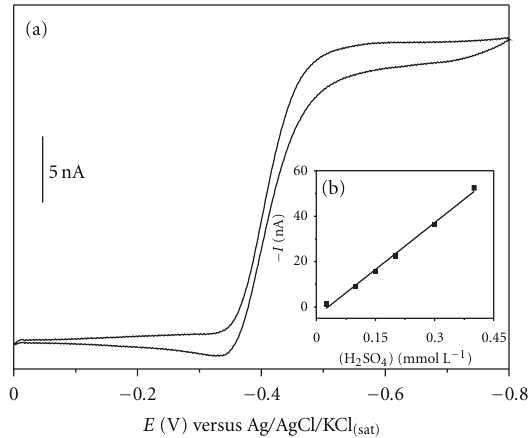
Figure 1: Cyclic voltammogram recorded with a platinum micro- electrode in a 0.2mmol L − 1 H 2 SO 4 + 0.1 molL − 1 KCl solution (pH = 3.4) (a) and calibration plot (b) Scan rate = 20 mVs − 1 .